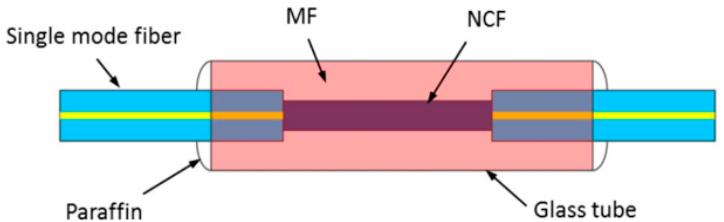
Figure 8. Schematic configuration of the structure of the sensing head of the remote magnetic field sensor based on intracavity absorption of evanescent field.